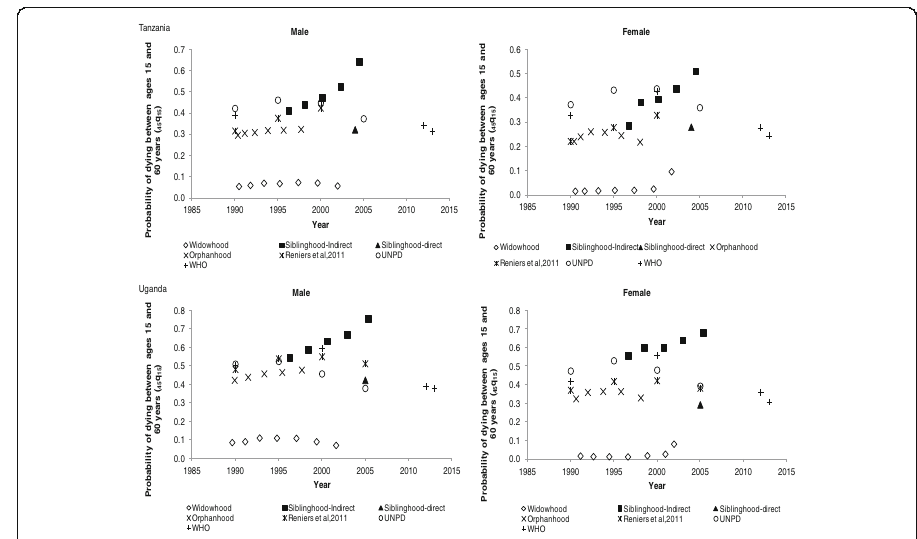
Fig. 5 Probability of dying between ages 15 and 60 years ( 45 q 15 ) by sex in Tanzania and Uganda